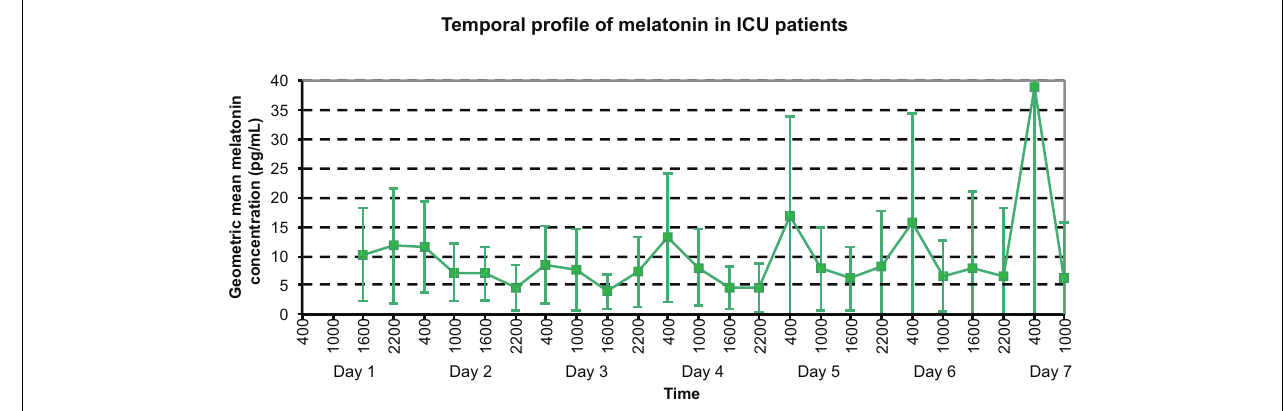
FIGURE 3 |Temporal profile of geometric mean serum melatonin concentrations in ICU patients, with peaks at varying times on the initial 3days, then peaks at 0400h on days 4–7 .